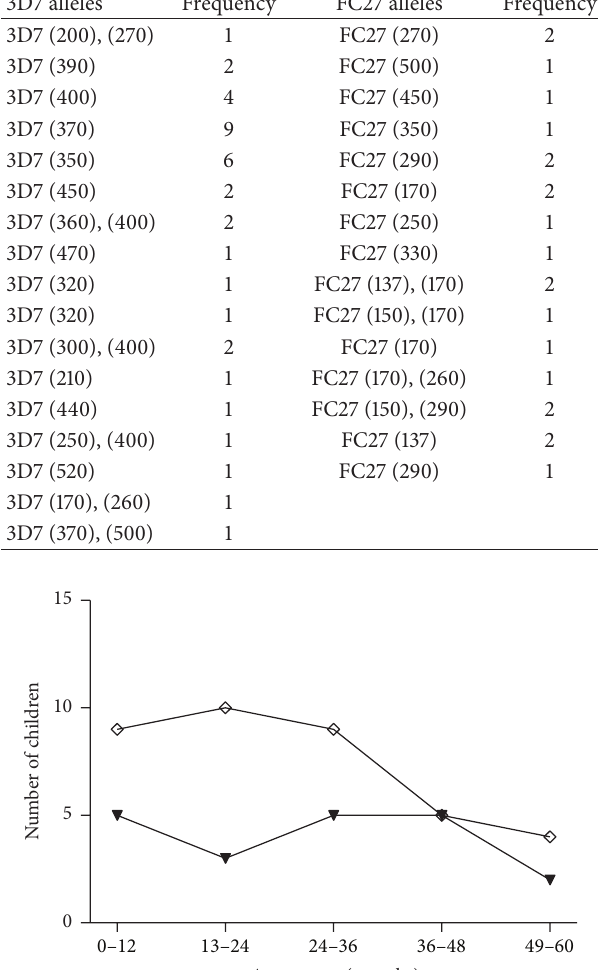
Table2:The3D7andFC27 P . falciparummsp2 allelesrecordedfrom children less than five years at Kibaha.